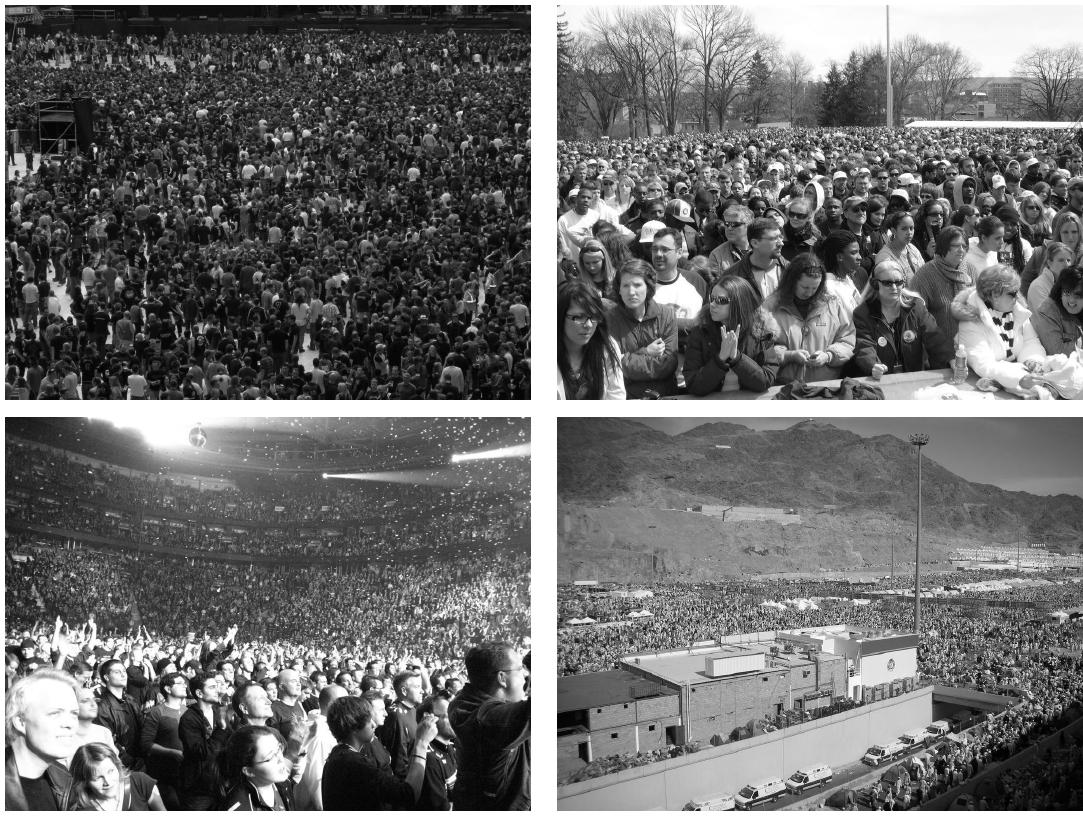
Figure 2. UCF_CC_50 crowd images